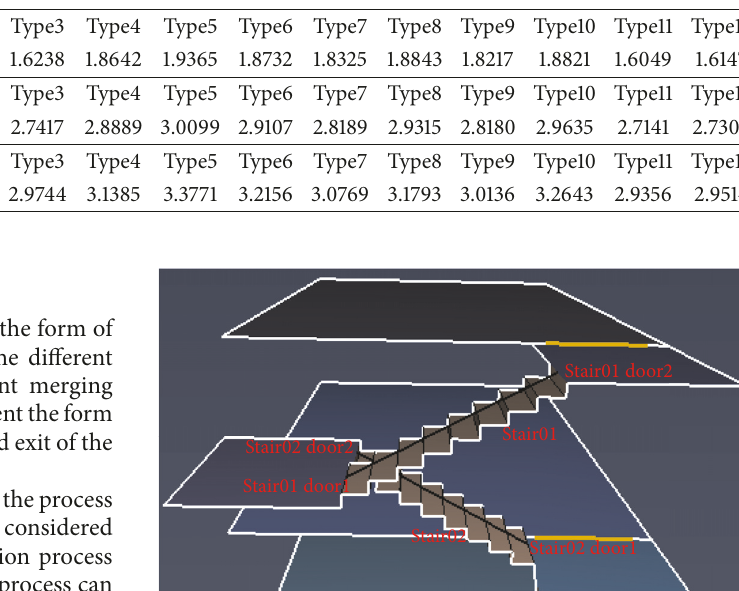
Table 2: The evacuation capacity of different merging form.